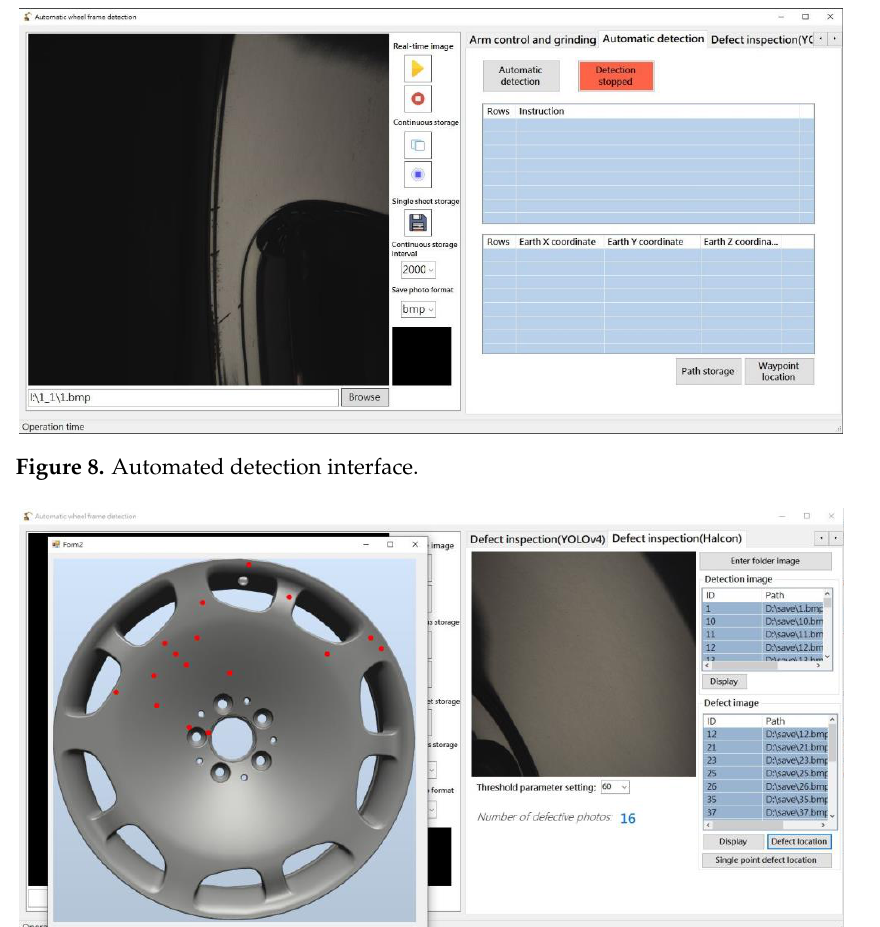
Figure 7. Basic control interface.